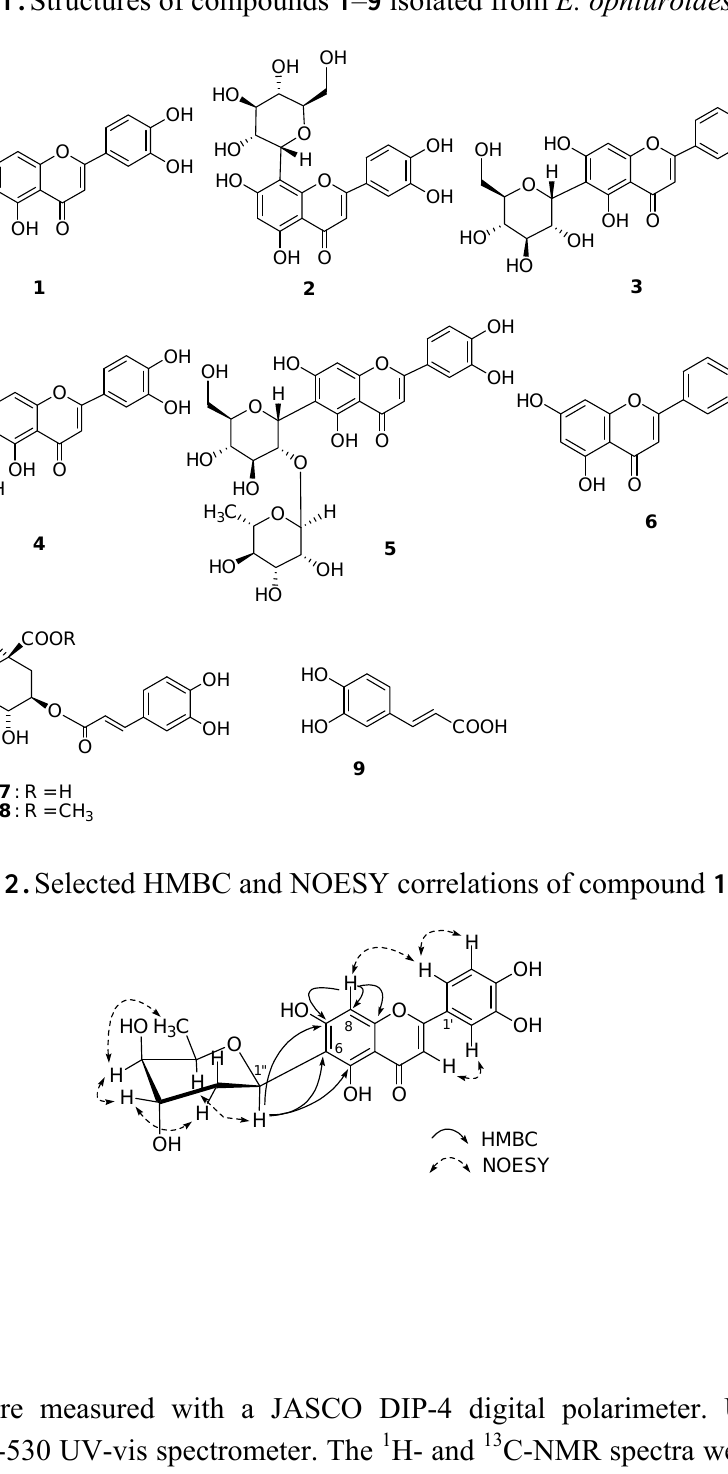
Figure 1. Structures of compounds 1 – 9 isolated from E. ophiuroides .